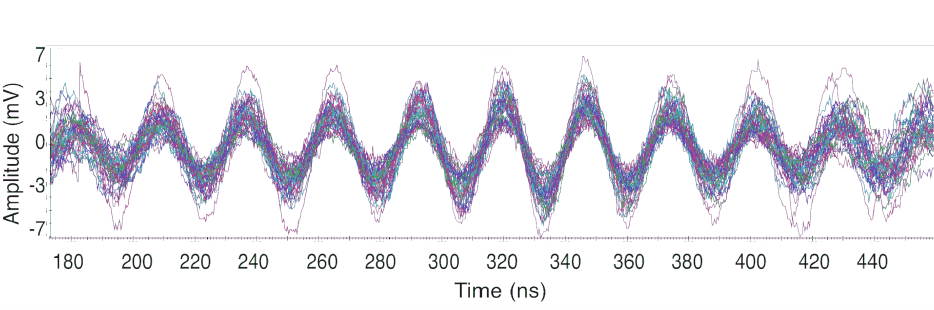
Figure 28: Zoom-in aligned traces for doubling operation with randomized